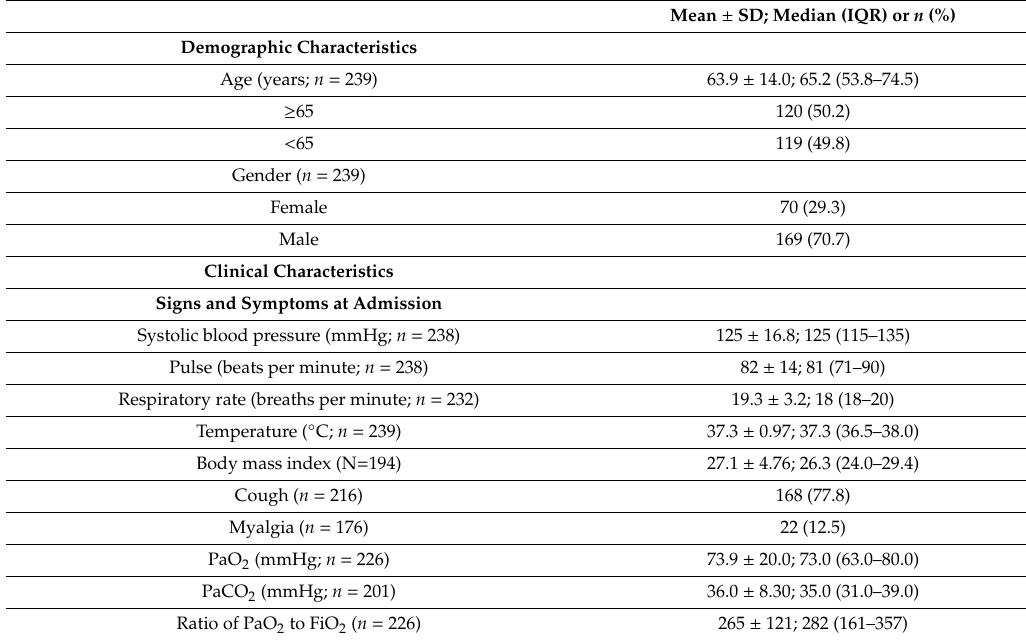
Table 1. Demographic, clinical, and laboratory characteristics of hospitalized Covid-19 patients ( n =